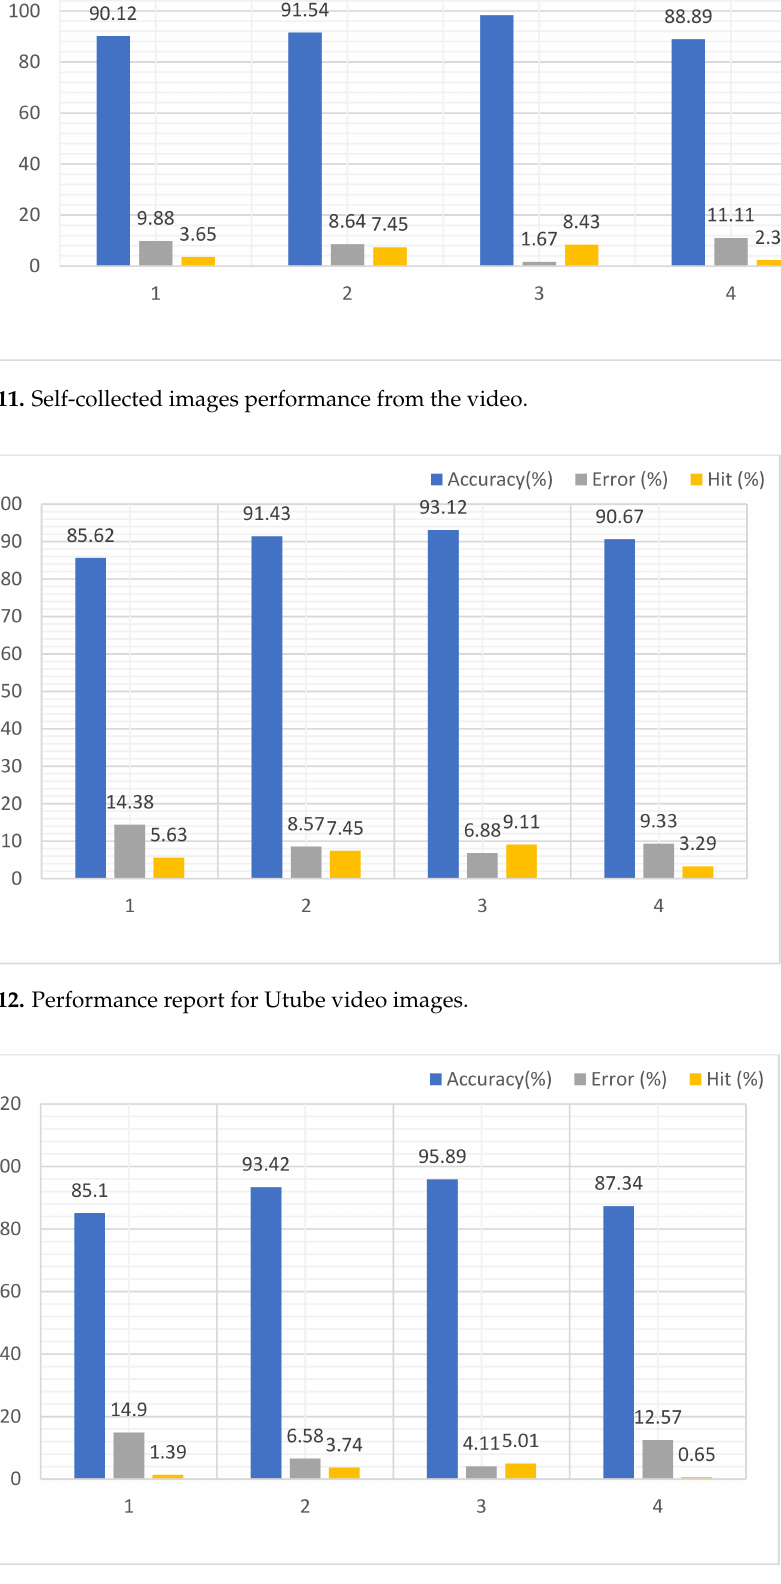
Figure 13. Performance report for Facebook